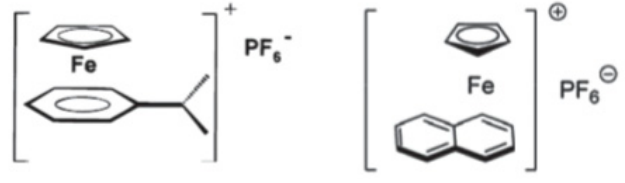
Figure 2. Schematic representation of some ferrocenium salts.